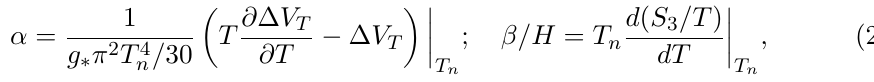
each FOEWPT data